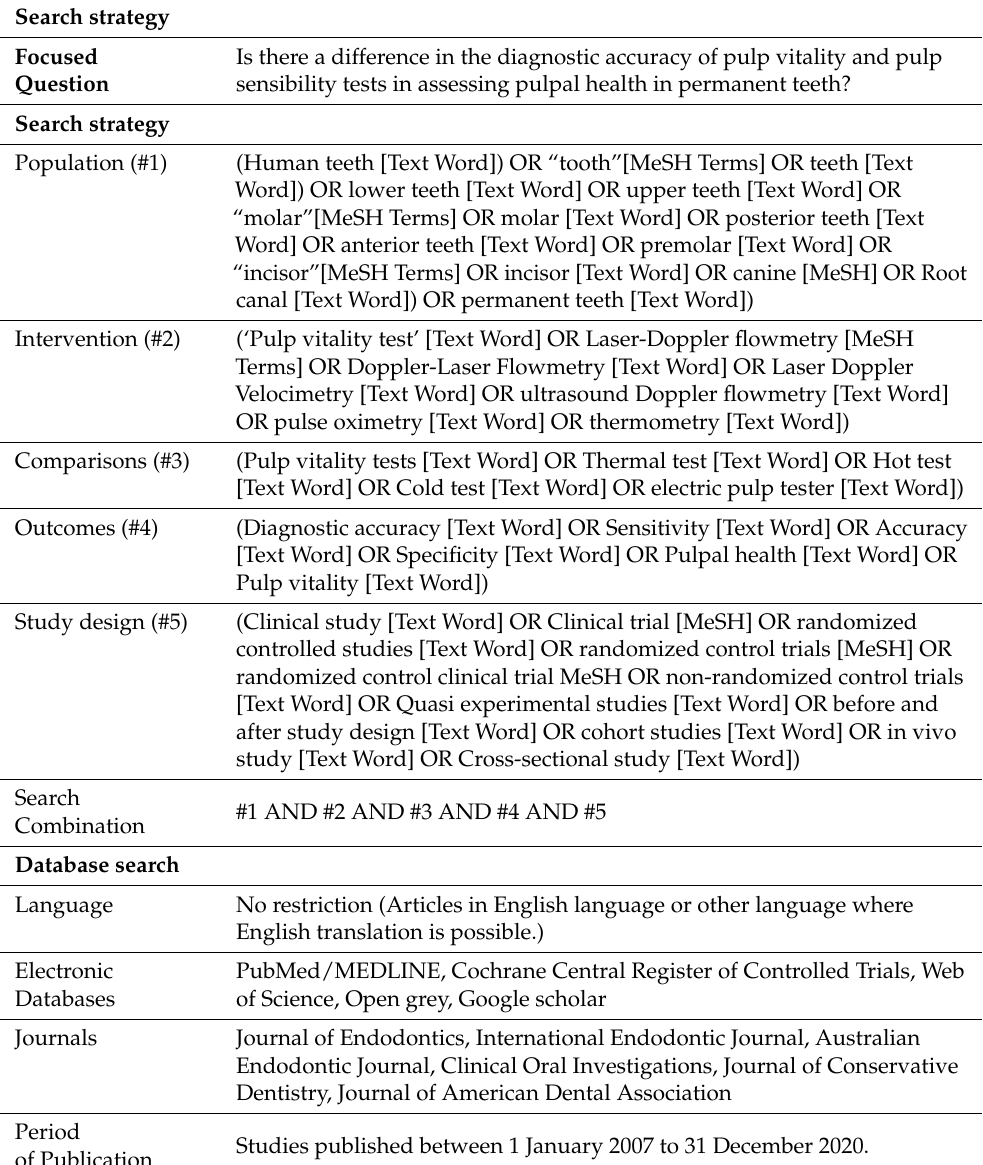
Table 1. The search strategy and PICOS